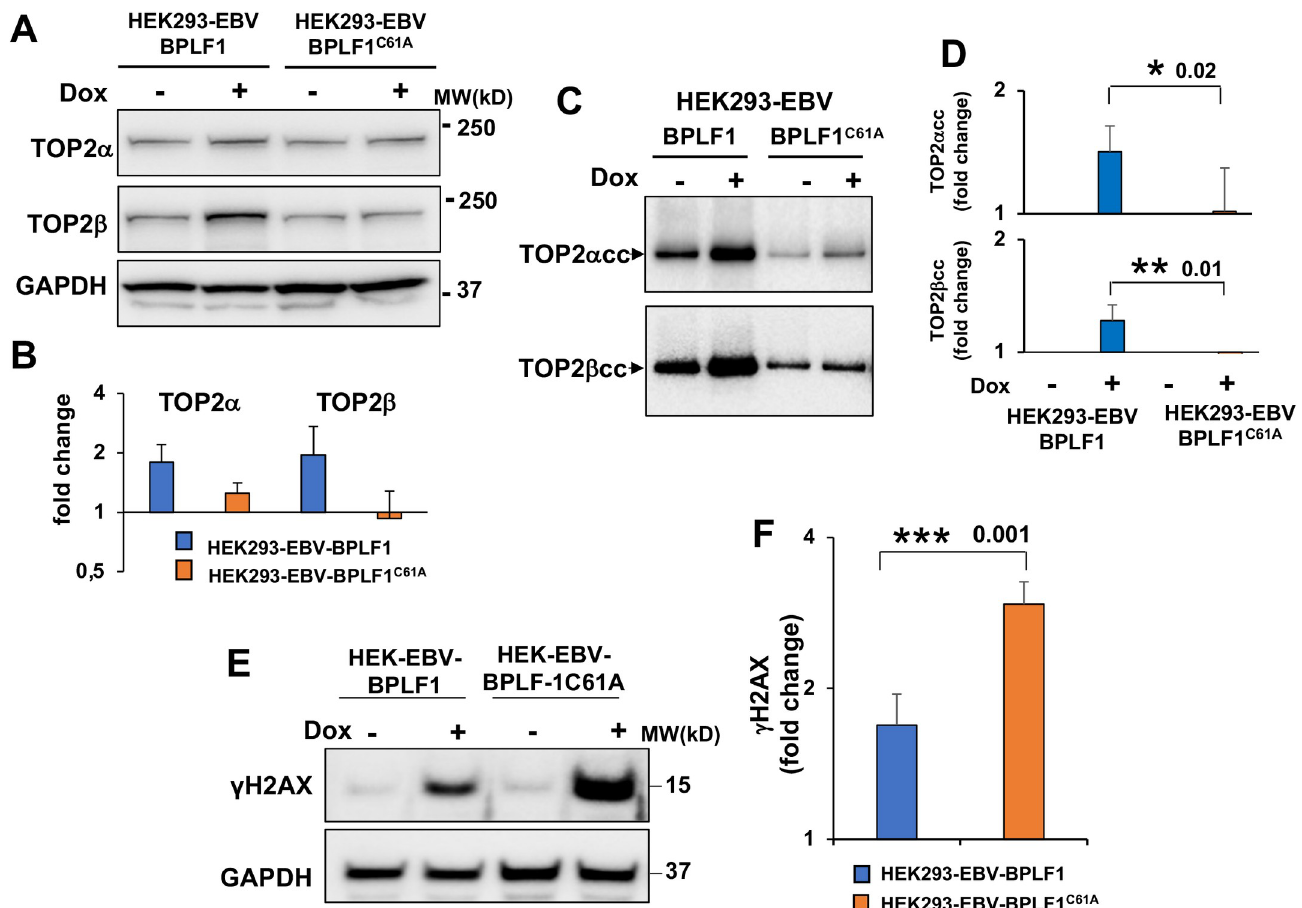
Fig 5. BPLF1 regulates the activity of TOP2 in productively infected HEK293-EBV cells. The productive virus cycle was induced by treatment with 1.5 μ g/ml Dox in HEK293-EBV cells carrying recombinant EBV encoding wild type or catalytic mutant BPLF1 and a tetracycline regulated BZLF1 transactivator. The expression of TOP2 α and TOP2 β was assessed by western blot and the intensity of the specific bands was quantified using the ImageJ software. ( A ) Representative western blots illustrating the small upregulation of TOP2 α and TOP2 β in cells expressing catalytically active BPLF1. ( B ) Densitometry quantification of the specific bands was performed using the ImageJ software and the values were normalized to the GAPDH loading control. The mean ± SD of three independent experiments are shown. ( C ) Representative RADAR assay illustrating the accumulation of TOP2 α and TOP2 β cleavage complexes in cells expressing catalytically active BPLF1. Western blots from one representative experiment out of three are shown. ( D ) The intensity of the DNA trapped TOP2 α and TOP2 β species was quantified using the ImageJ software. The mean ± SD fold increase in induced versus non induced cells recorded in three independent experiments is shown. Statistical analysis was performed using Student’s t-test. � P � 0.05; �� P � 0.01. (E) Representative western blot illustrating the expression of the DDR marker γ H2AX in induced HEK293-EBV cells expressing catalytic active or inactive BPLF1. (F) The intensity of γ H2AX bands were quantified by densitometry in three independent experiments. The fold increase in induced versus control cells was calculated after normalization to the GAPDH loading control. Statistical analysis was performed using Student’s t-test. ��� P � 0.001.